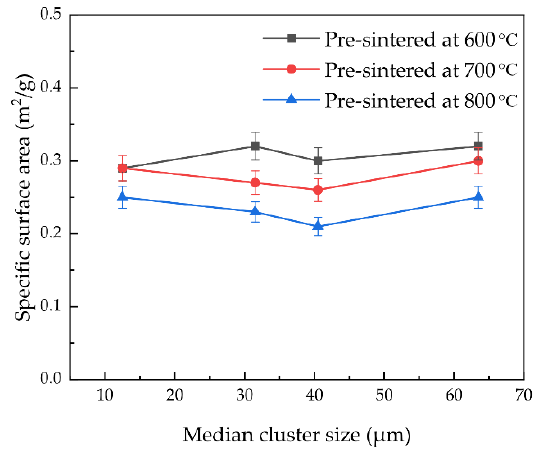
Figure 5. Specific surface area versus median cluster size.